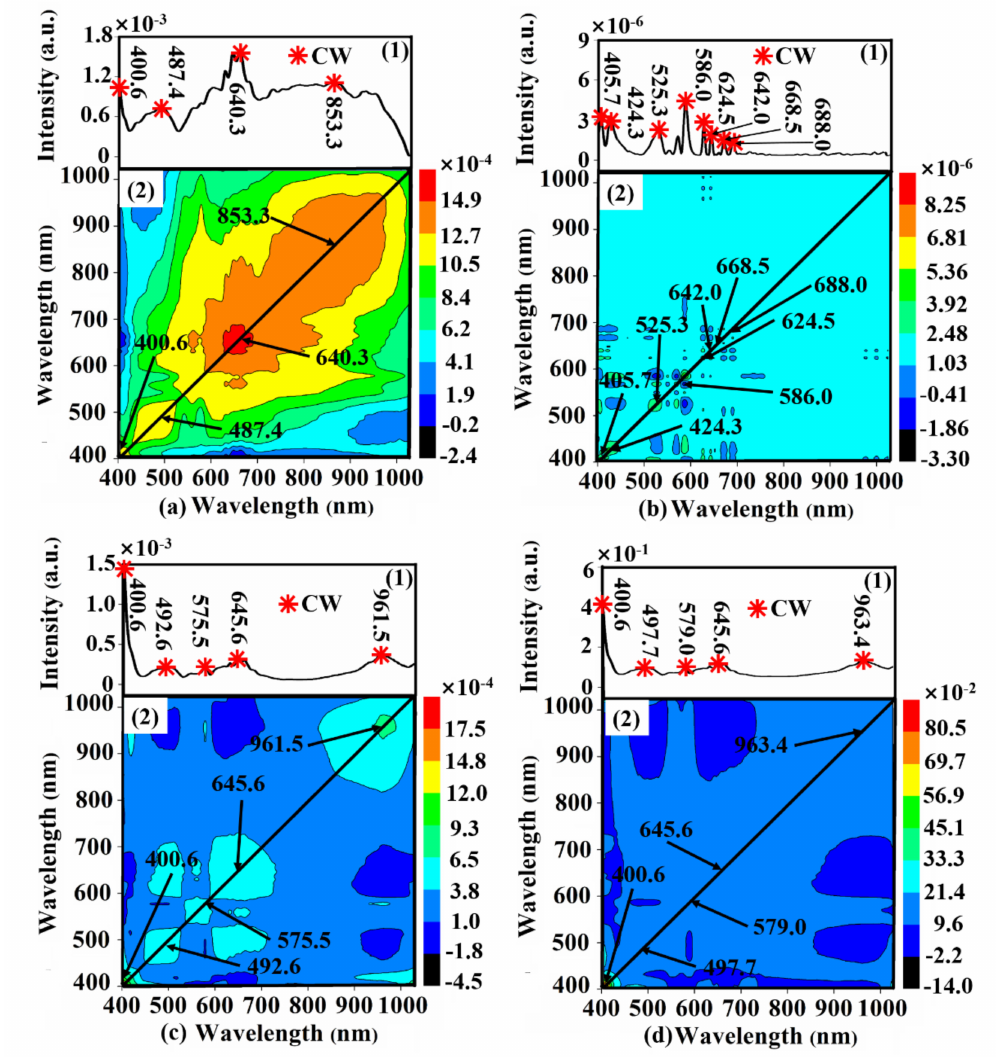
Figure 6. The 2D-COS spectrum maps of the belly region, which were preprocessed by ( a ) SG, ( b ) FD, ( c ) MSC, and ( d ) SNV,